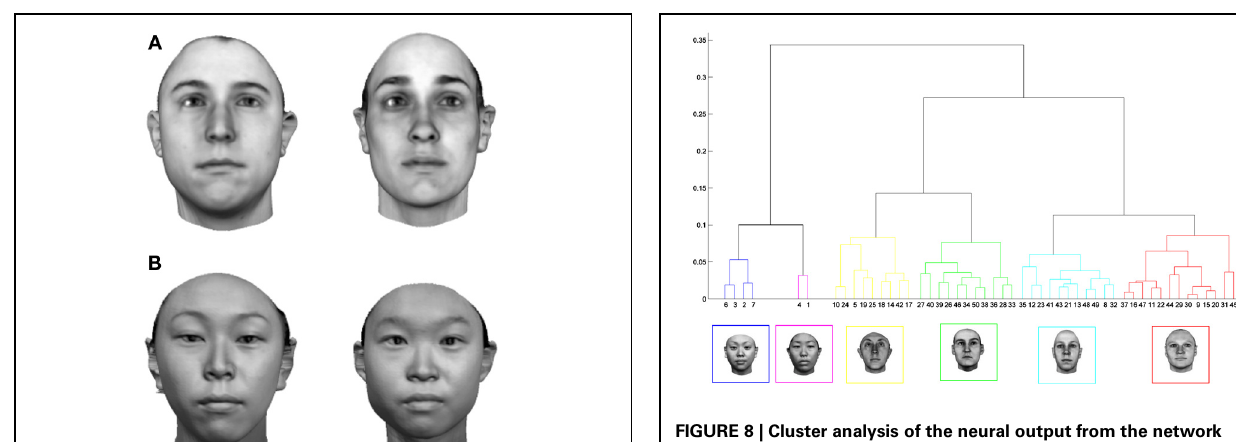
FIGURE 8 | Cluster analysis of the neural output from the network represented in graphical format. An example face from each of the six major clusters appears along the horizontal axis. There is a clear tendency for the system to produce consistent responses to subsets of the input stimuli. Of particular note is the differentiation of German and Japanese faces. The difference represents the primary bifurcation of the dendrogram, suggesting little overlap in the groups of neurons responding to the two racial